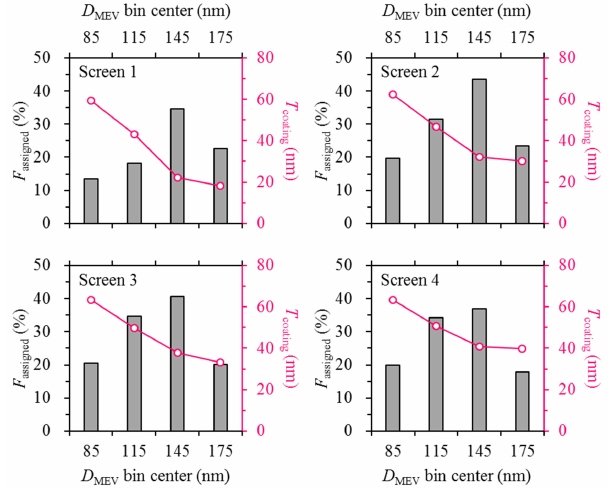
Figure 11. Dependence of coating thickness ( T coating ) on rBC core size ( D MEV ) for successive flight screens of the transformation flight F_9/4. To derive the dependence, rBC-containing particles de- tected by the SP2 are divided into four equal-width bins according to their core sizes ( D MEV ) , the centers of which are 85, 115, 145 and 175nm, respectively. The lower edge of the first D MEV bin is 70nm, corresponding to the SP2’s lower detection limit of D MEV ; the upper edge of the last D MEV bin is 190nm. The D MEV range of 70 to 190nm accounts for approximately 95% of the detected rBC cores. For each D MEV bin, the fraction of rBC cores that can be as- signed a coating thickness ( F assigned , in percentage) is also shown.